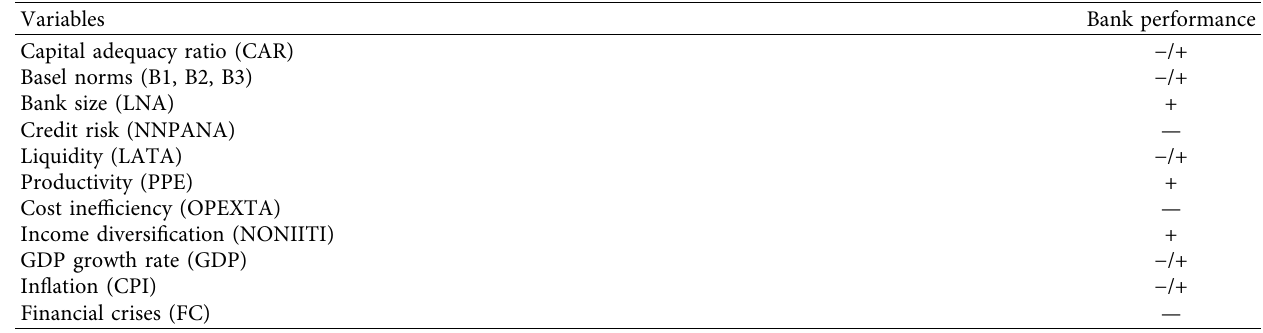
Table 2: Expected relationship of study